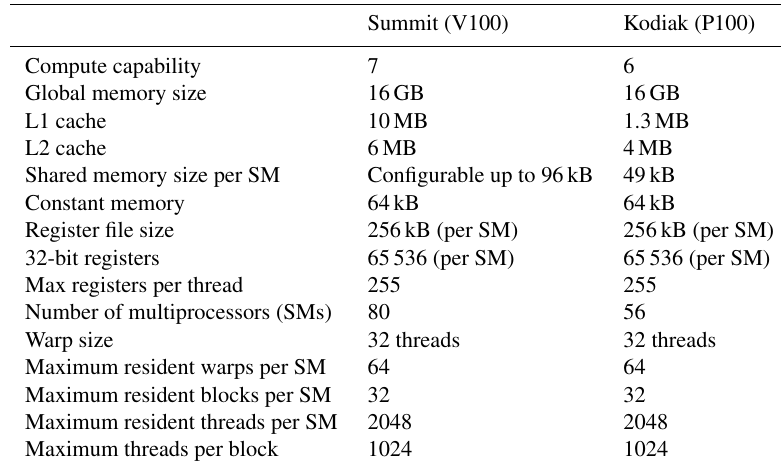
Figure 1. A schematic representation of the WAVEWATCH III code structure. Table 1. GPU hardware